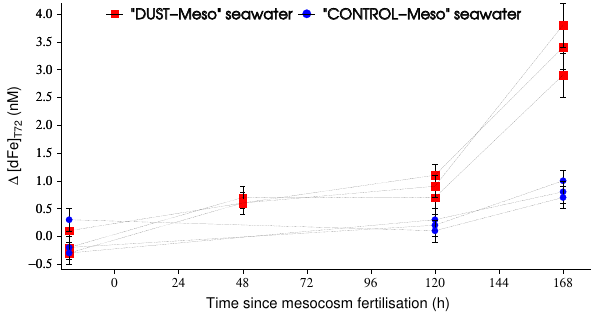
Fig. 4. Results from dust dissolution in batch experiments with fil- tered seawater collected in the mesocosms. The X axis corresponds to the time of collection of the filtered seawater in the mesocosms and addition of dust to the batch reactor (Teflon bottles). It indi- cates the time spent since the mesocosm fertilization. The Y axis corresponds to the dissolution measured after 72h of contact time between dust particles and seawater in the batch reactors. Dissolu- tion is expressed as the difference between [dFe] in seawater after 72h of contact time and [dFe] at the time of the water collection in the corresponding mesocosm ( 1 [dFe] 72h in